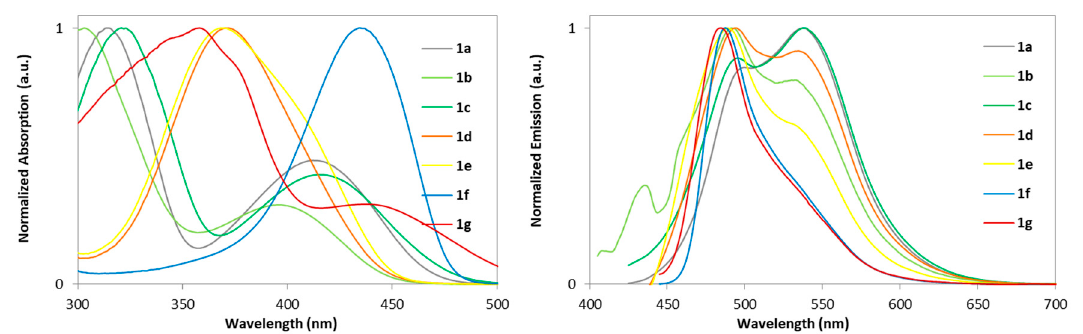
Figure 2. Absorption ( left ) and emission ( right ) spectra of boron complexes in THF solutions. Table 1. Absorption and emission properties of the complexes 1a – g . THF Solution Complex